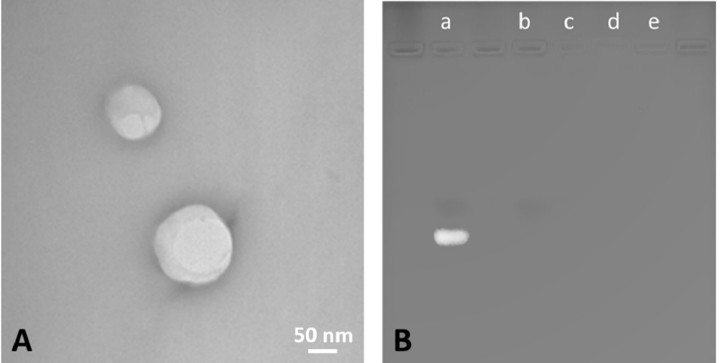
Figure 2. ( A ) TEM image of siNrf2-NBs (magnification 39,000×, scale bar 50 nm). ( B ) The gel retardation assay using electrophoresis on agarose gel of (a) naked siRNA, (b) blank NBs, (c) siNrf2- NBs, (d) siNrf2-NBs stored at 4 °C for 6 months, and (e) siNrf2-NBs after 6 h of incubation in PBS, pH